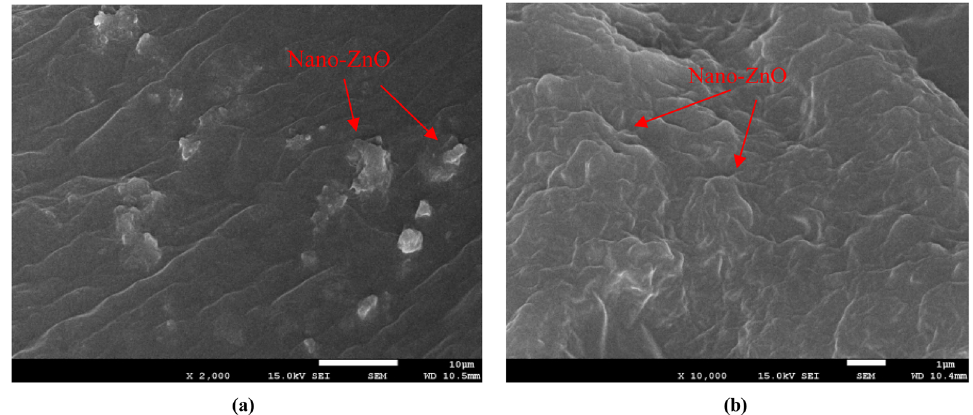
Figure 6: Di ff erent magni fi cation images of nano - ZnO - modi fi ed asphalt: ( a ) nano - ZnO - modi fi ed asphalt ampli fi es 2,000 times and ( b ) nano - ZnO - modi fi ed asphalt ampli fi es 10,000 times.